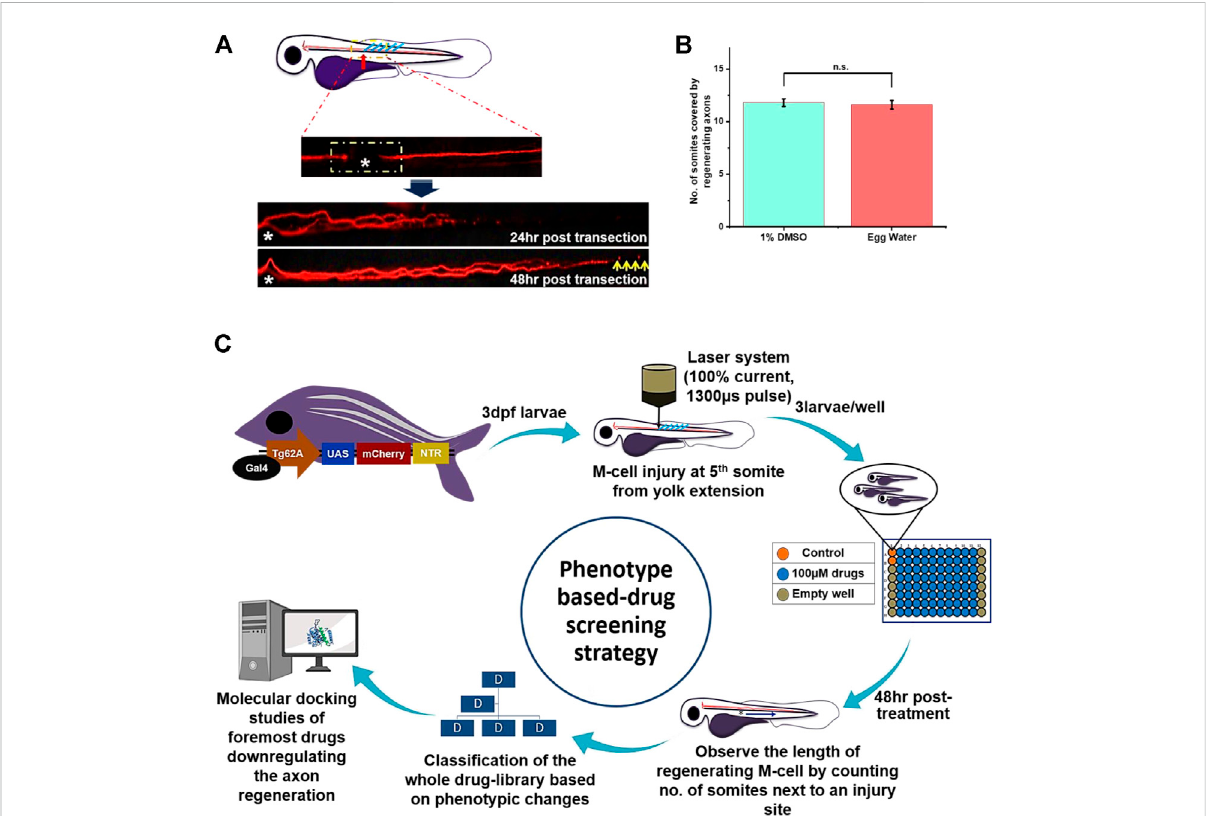
FIGURE 1 Schematic representation of phenotype-based drug screening strategy: (A) Before the start of the experiment, we chose the laser axotomy for consistency ofthephenotype.Eachtime con fi rmation oftheaxotomizedM-cellwasdonebyseeingthegapbetween theproximalanddistalpartof the axon under the fl uorescence microscope. The time course of the M-cell regeneration and time-point for result observation was decided by observing the whole regeneration process starting from 8 h to 56 h till the completion of the regeneration process. At 48 hr-post-axotomy, recoveryofM-cellregenerationwouldnotbecompletedandstill,ithasfewdistances torecover(asshownbytheyellowarrow).Soweselectedthis timepointtoobservethePDSresults. (B) Next,weobservethatwild-typelarvaetreatedwith1%DMSOandeggwaterhadnosigni fi cantdifferencein axon regeneration, and M-cell usually recovered 10 – 14 somites within 48 hr-post-axotomy. So less than eight somites are assumed to be slow and more than 14 are assumed to befast regenerating M-cell. (C) The plan of action for phenotypicdrug screening starts with laser axotomy of M-cell in 3dpflarvaeof Tg(hsp:Gal4FF62A;UAS:nfsB-mCherry). To fi xthepositionofaxotomyinlarvalzebra fi sh,eachtimeaxotomywasperformedatthe5 th somite from yolk extension (towards anterior body part). Three larvae were taken in each well; the color of the well shown above presents experimental groups like the orange for the control group, the blue for the compound treated group, and the gray for the empty well. Each time 80compoundswerescreenedper96wellplatesbyleaving rows1and12empty.Further,basedonphenotypicresponsewholelibrarywasclassi fi ed into three groups and subgroups. Further, four drugs that severely affecting the axon regeneration of M-cell were selected for molecular docking studies with the target proteins to predict the target signaling